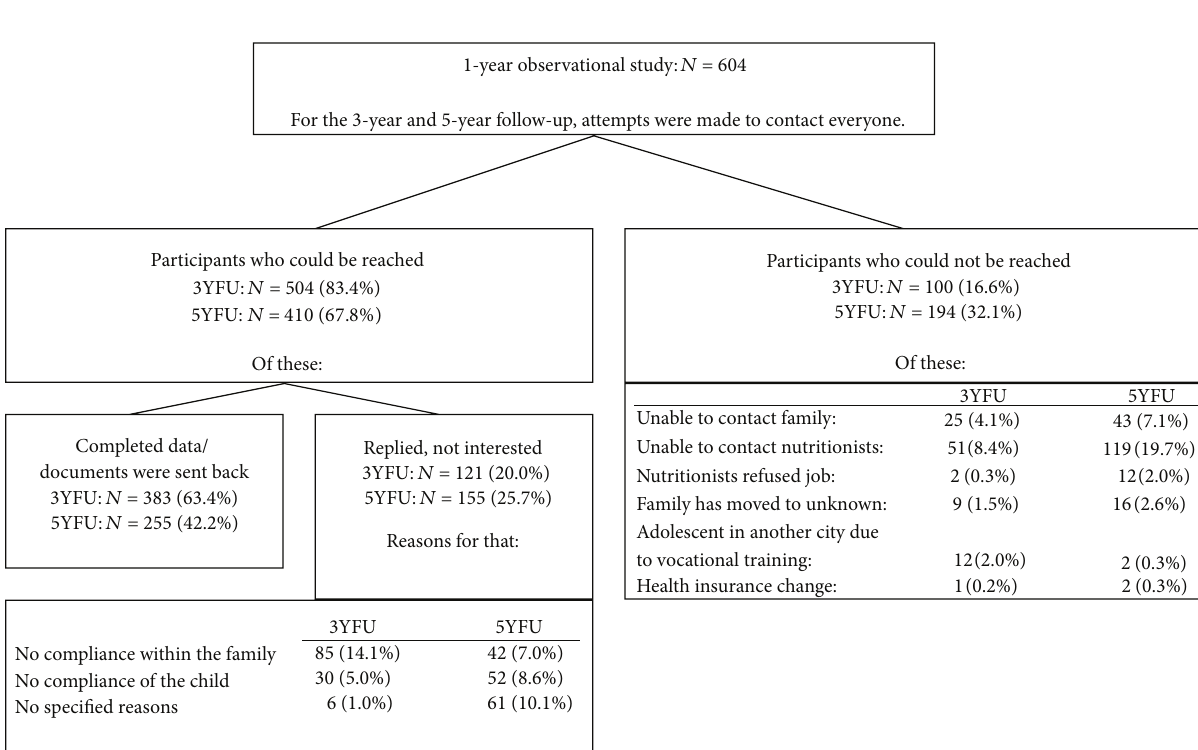
and two families for the five-year follow-up could not be contacted